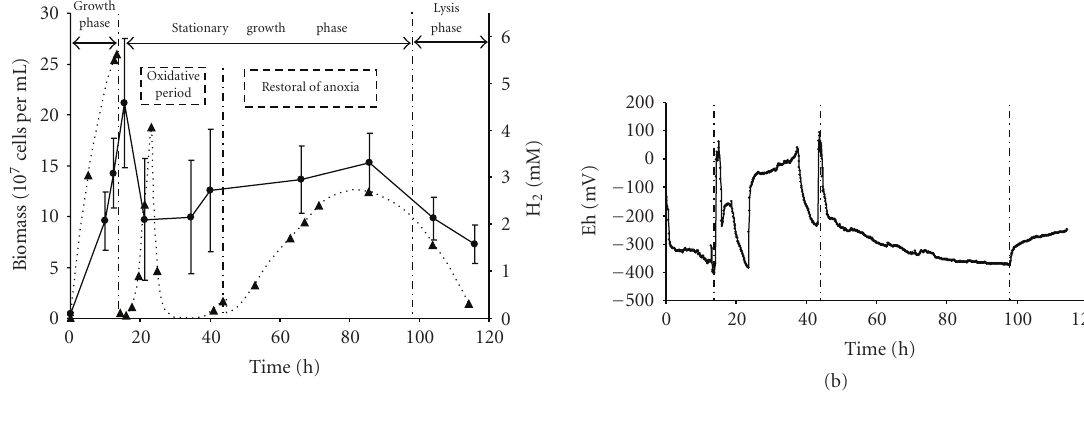
Figure 2: Growth of Thermotoga maritima cultivated in a bioreactor under anoxic conditions including oxidative period: (a) biomass ( and H 2 production ( ), and (b) redox potential (Eh). (cid:2) anoxic conditions (44.6 to 97 hours), and (iv) the lysis phase from 97 to 114.2